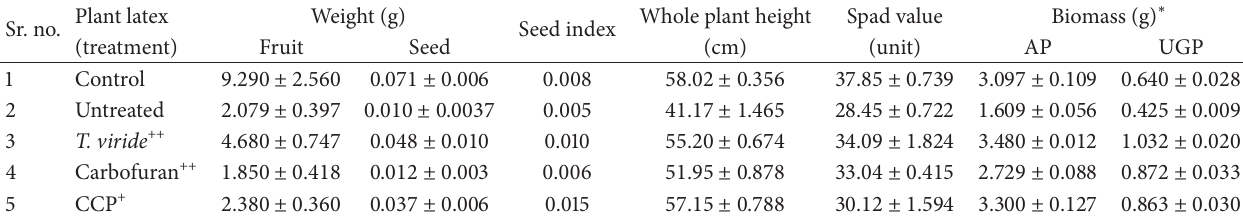
Table 8: Morphological observations of experimental plants on exposure of protease and standard